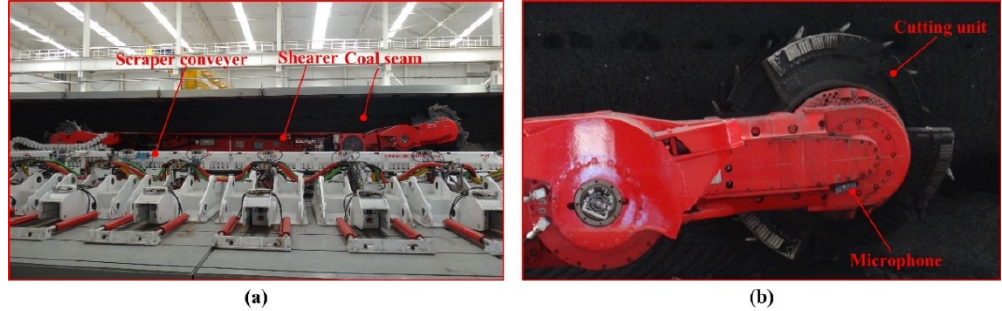
Figure 11. ( a ) The arrangement of the shearer; ( b ) the arrangement of the cutting sound collection system.